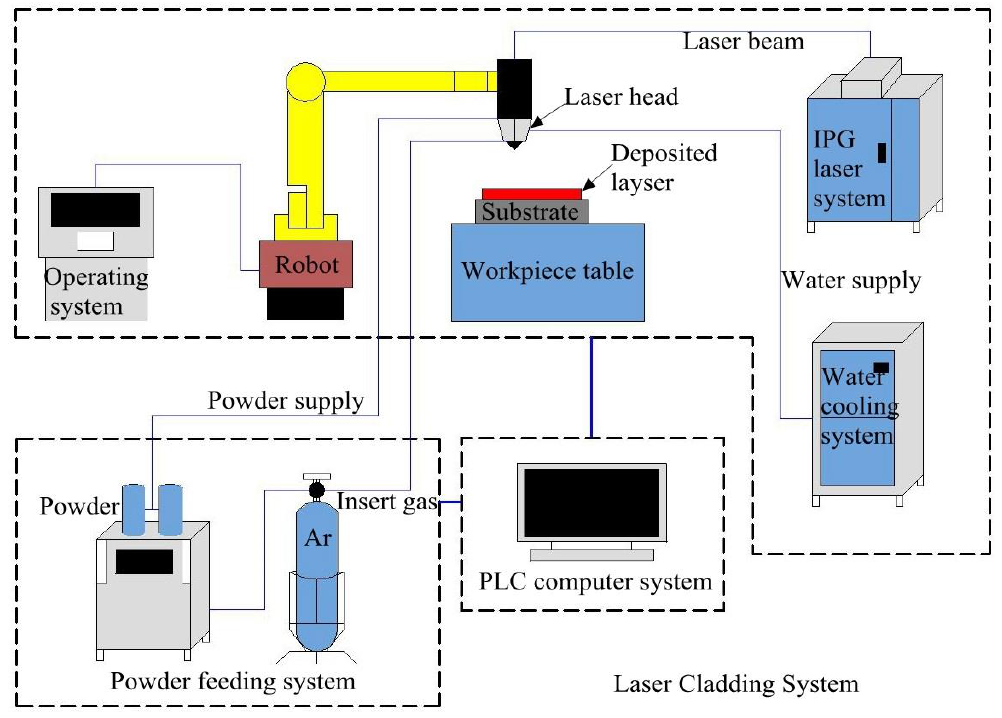
Figure 2. Laser cladding system.